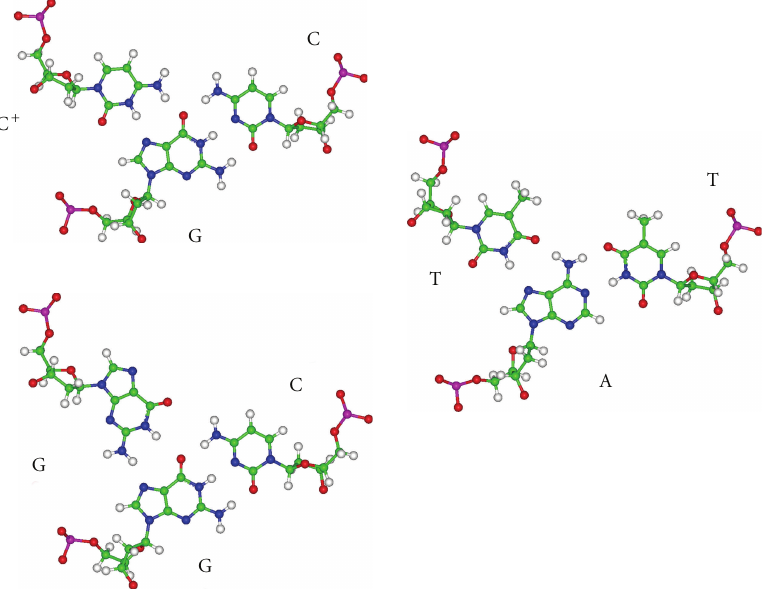
Scheme 1: Hypothetical triads in parallel-G,T and parallel-C,T